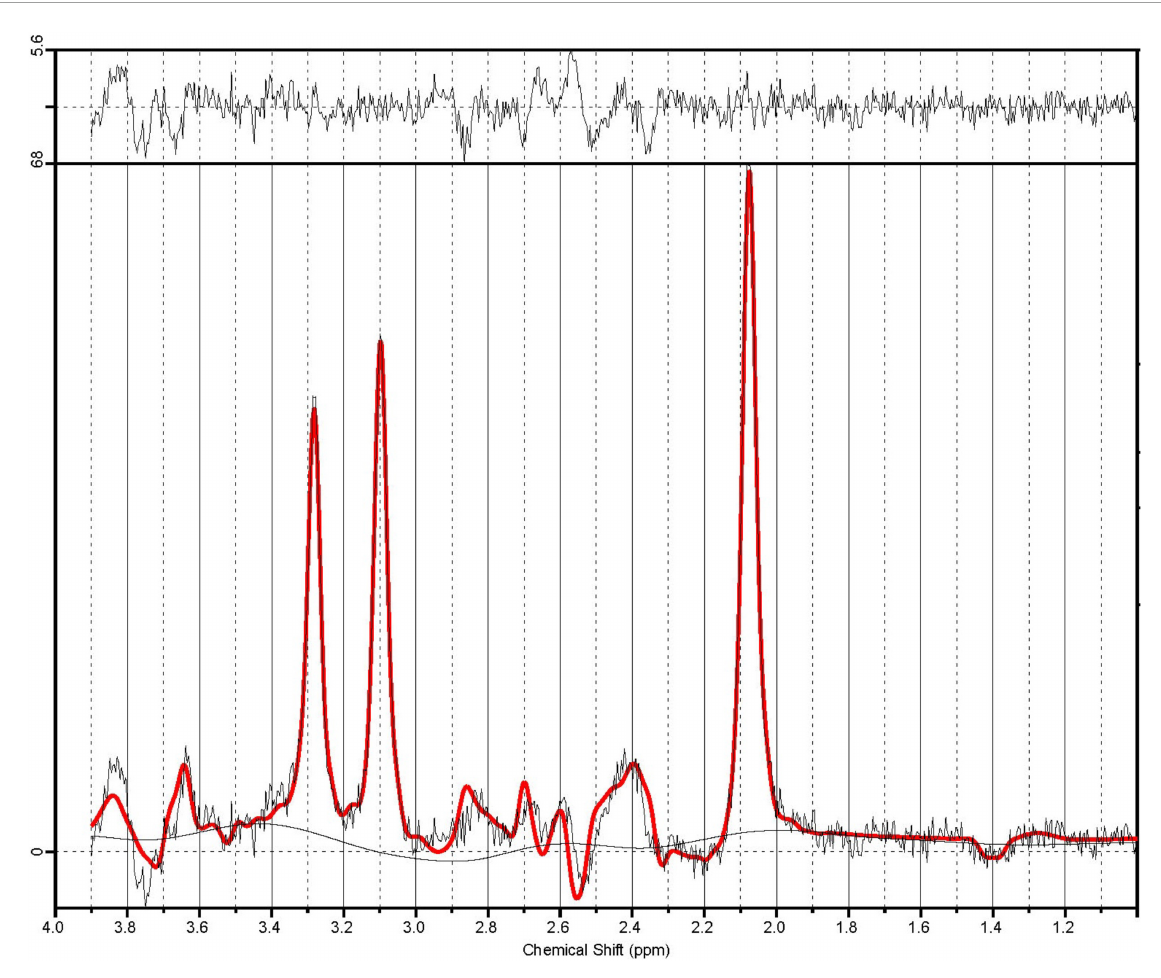
FIGURE2 A sample PRESS spectrum with sequence timings optimized for recovering signal from glutamate (PRESS TE1,2 = 90.80 ms). The spectra in illustrate the unfiltered data superimposed with the LCModel fit in red. The residual noise is shown above.